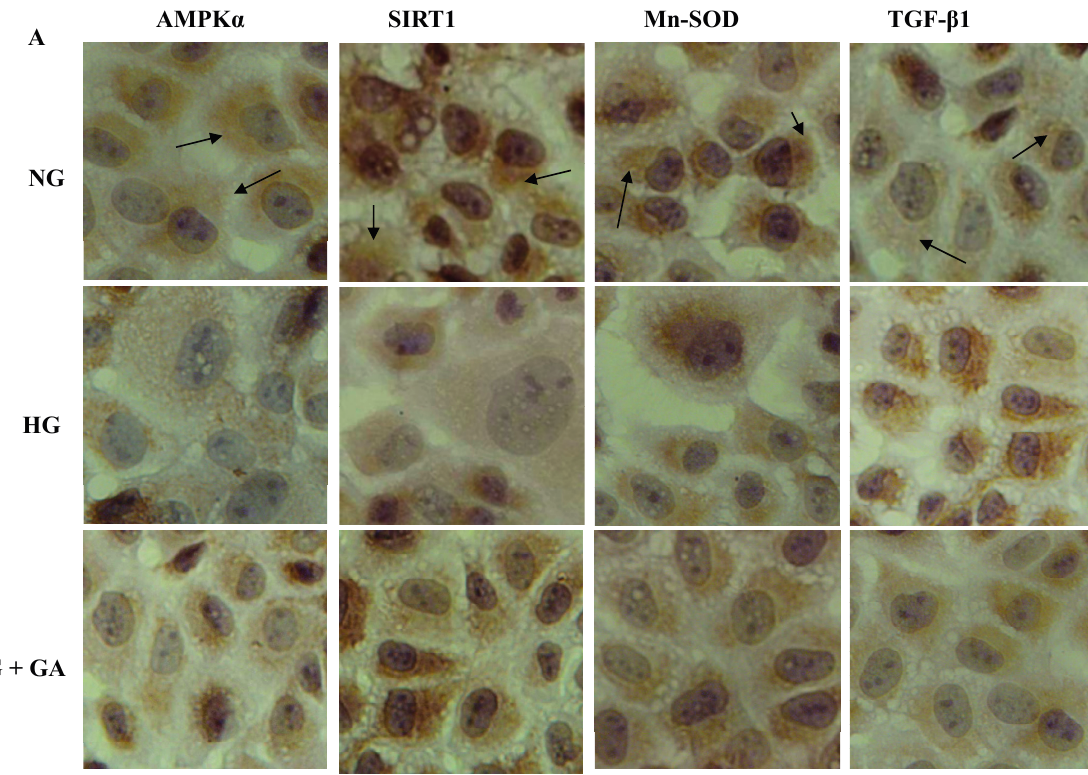
Figure 5. Immunohistochemistry and immunofluorescence analyses. ( A ) NRK-52E